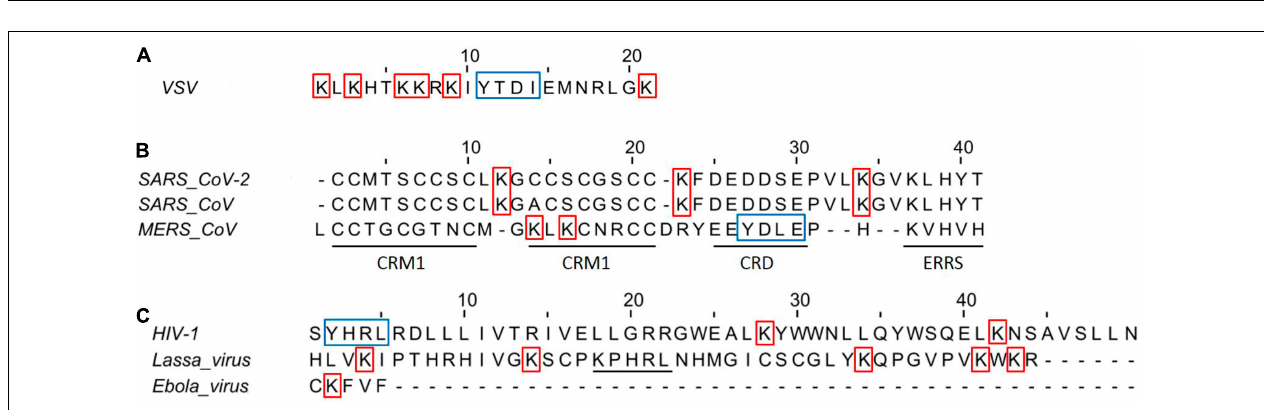
FIGURE 2 | Tridimensional structures of Vesicular Stomatitis Virus G protein and the main class I viral fusion proteins in pre-fusion static conformations. (A) Vesicular Stomatitis Virus (VSV) class III fusion glycoprotein (PDB: 6TIT) and representative class I viral fusion proteins: (B) SARS-CoV-2 S (PDB: 6VXX), (C) HIV glycoprotein (GP) 160 (PDB: 6ULC), (D) Lassa virus GP (PDB: 6P91), and (E) Ebola virus GP (PDB: 6QD7). They form homotrimers with two domains, the C- and N-terminal domains (Magenta, green, and cyan represent each monomer). N terminal contains the receptor binding site and C terminal domain contains two heptad repeats (HR), a single-pass transmembrane motif, and a cytoplasmic tail (CT).